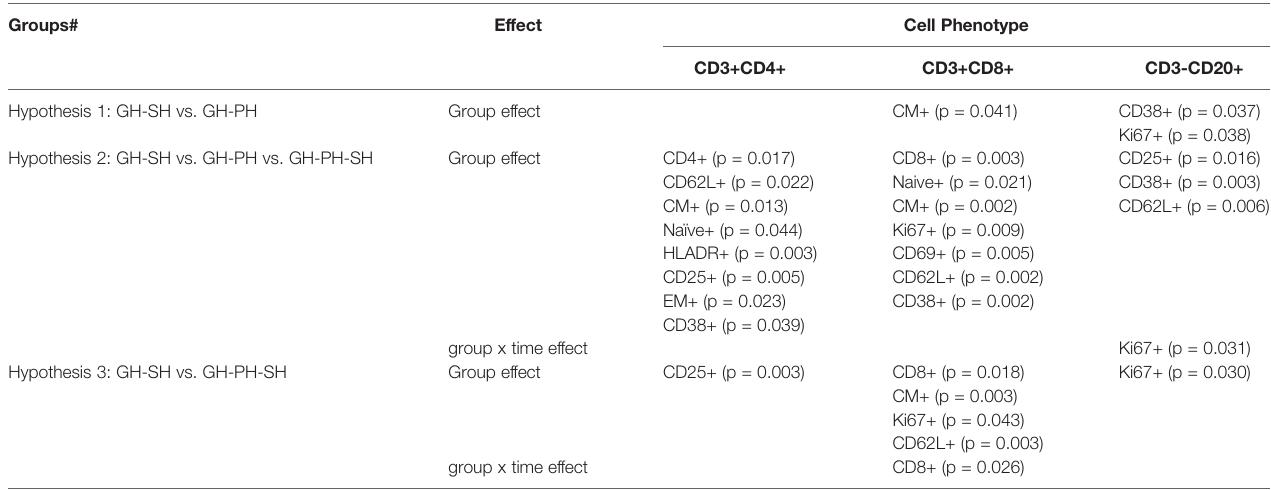
TABLE 1 | Signi fi cant changes in the frequency of peripheral T and B cell subpopulations.